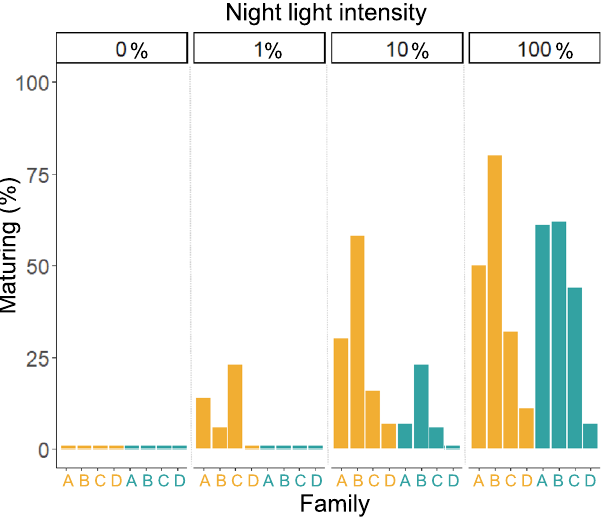
Figure 2. Impact of light treatment and family on maturation status. Percent of individuals maturing in each light treatment and family. High light intensity groups are presented in orange, while the low light intensity groups are presented in